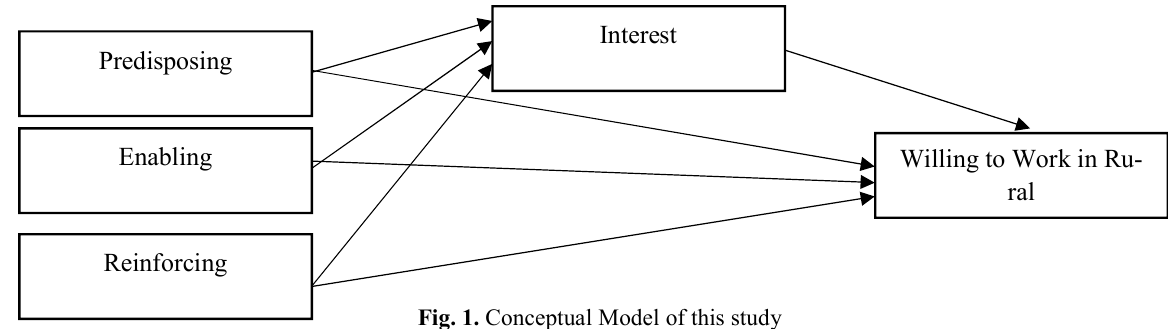
Fig. 1. Conceptual Model of this